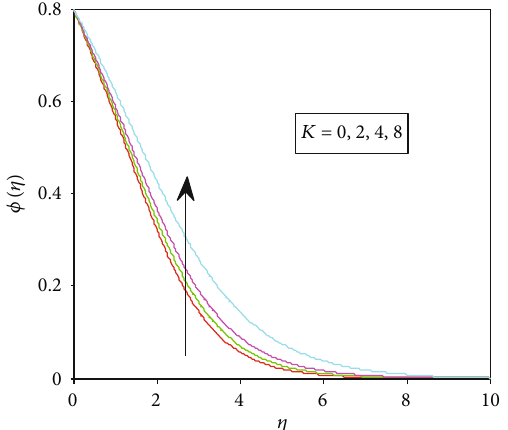
Figure 17: Concentration distribution for di ff erent values of the couple stress parameter.